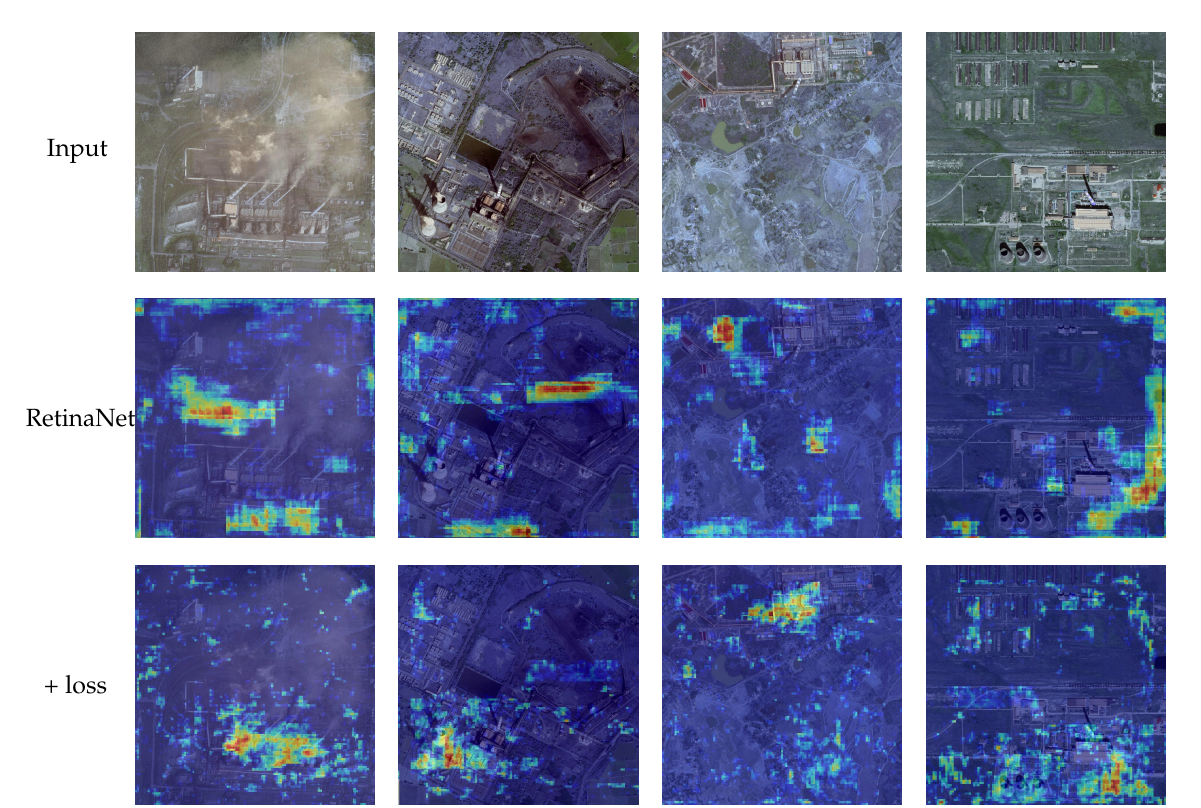
Figure 6. Several input images and corresponding heat map visualization of feature representation in ablation experiments, which proves that part-based attention module can help pay more attention to the distinctive components in the training process. First line: input image examples. Second line: heat map visualization results of RetinaNet for corresponding images. Third line: heat map visualization results of RetinaNet + the loss function defined in part-based attention